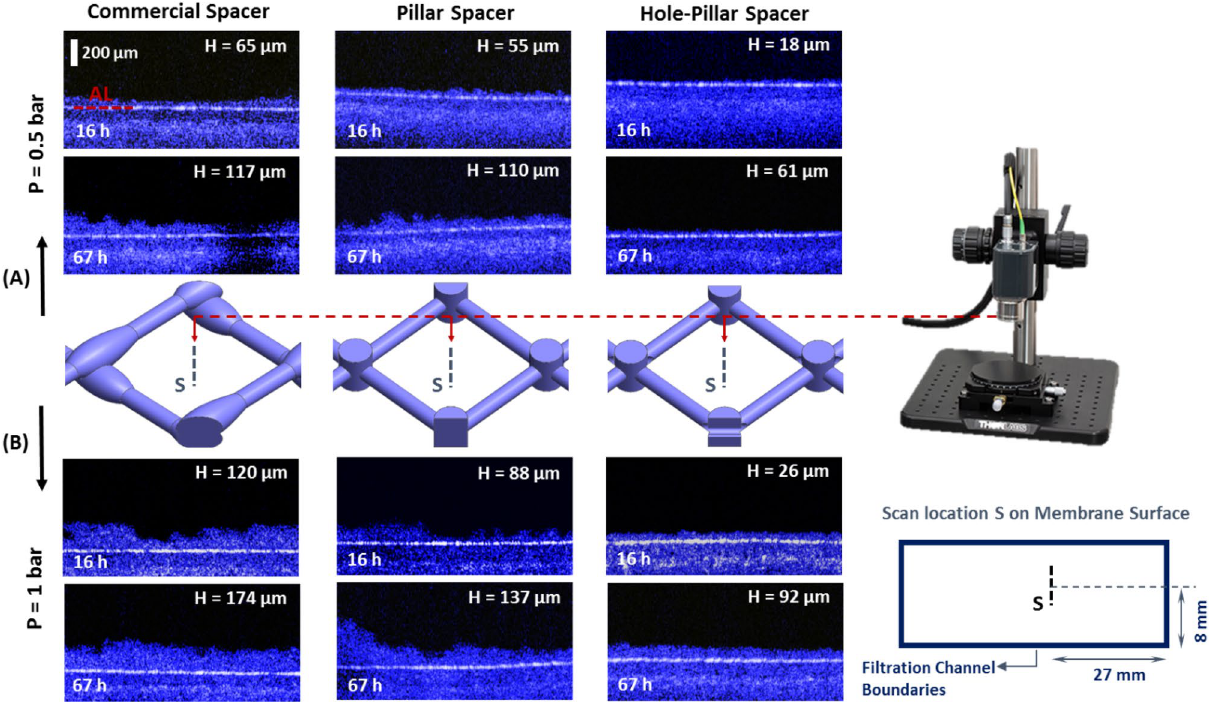
Figure 8. OCT scans taken at line S located at the center of the spacer cell. Biofilm variation on the membrane surface for the three tested feed spacers at applied pressures of P = 0.5 bar ( A ), and P = 1.0 bar ( B ) taken at 16 h and 67 h of filtration process. The scale bars of all images are the same. AL line represents the membrane active layer. Below AL is the membrane support layer and above is the deposited